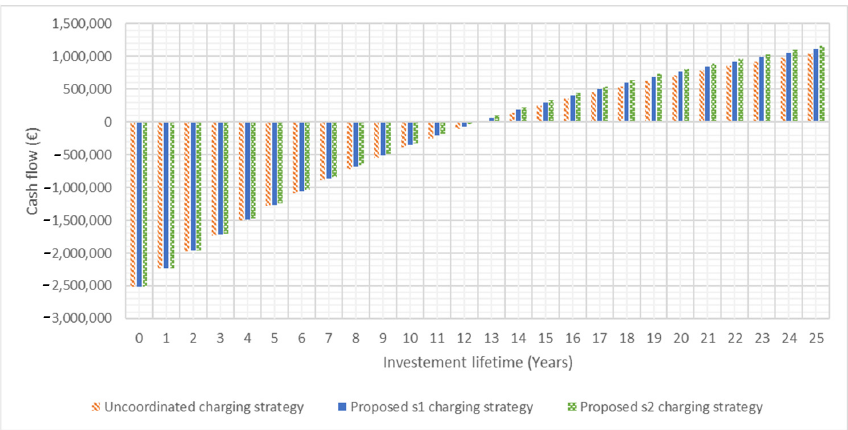
Figure 14. Accumulated present value savings throughout the investment years (PV = 3000 kWp).